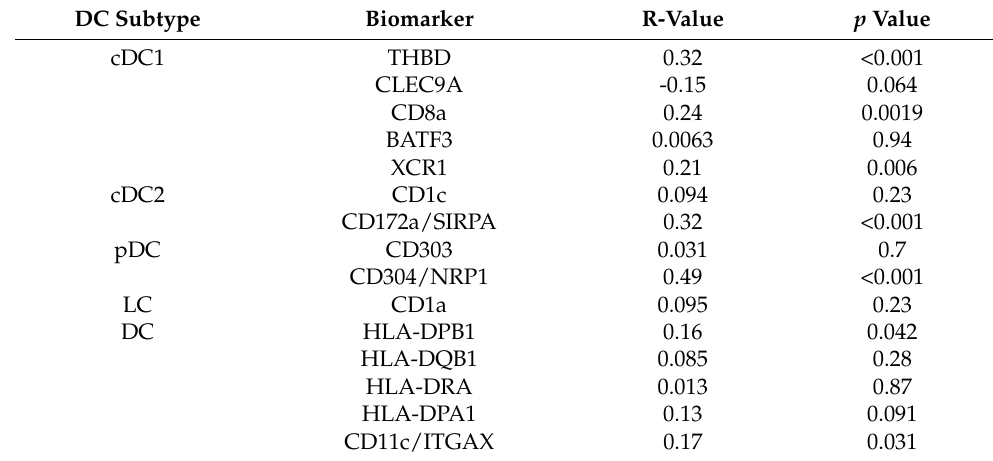
Figure 6. Relationship between H6PD and immune checkpoints in GBM. Higher expression of eight checkpoints in GBM was detected ( A ). Correlation between H6PD and immune checkpoints in GBM